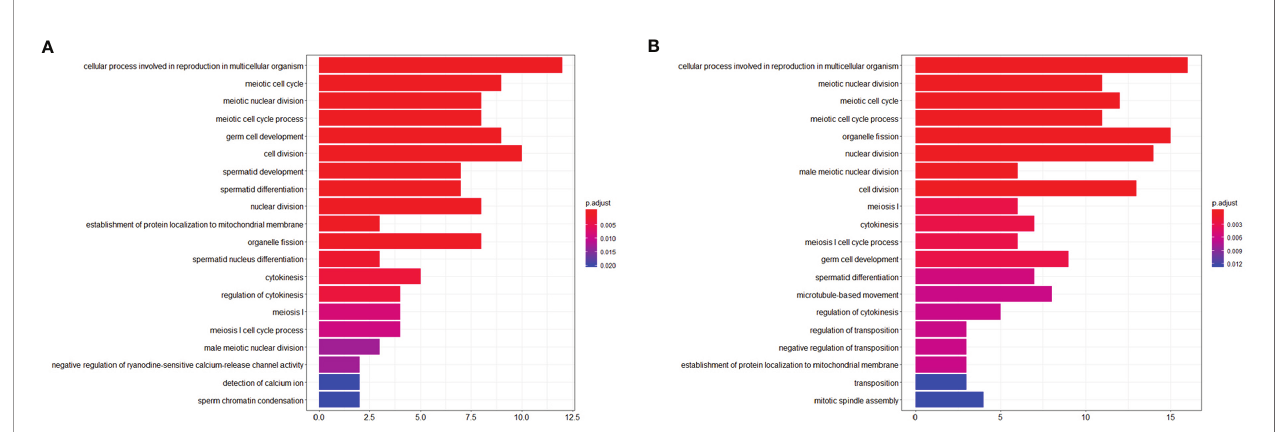
FIGURE 3 | Visualization of Biological process of Gene ontology (GO). (A) GO term enrichment of downregulated markers between control group and RS+IS 14-day group. (B) GO term enrichment of downregulated markers between control group and RS+IS 21-day group. GO analysis showed signi fi cant enrichment terms of downregulated markers, indicating stress affected the normal function of male germ cells.